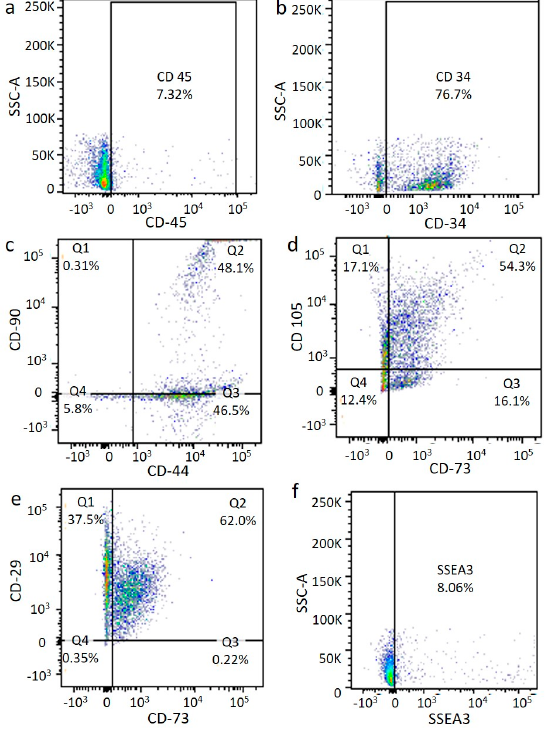
Figure 6. Flow cytometry after enzymatic digestion. Immunophenotyping analysis of ASCs at p 0 from enzymatic digestion. Cell markers CD45 ( a ), CD34 ( b ), CD44/CD90 ( c ), CD73/CD105 ( d ), CD73/CD29 ( e ), and SSEA3 ( f ).